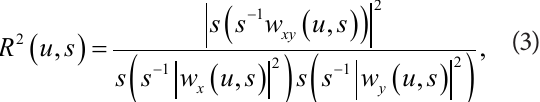
Table 1 indicates that daily mean returns